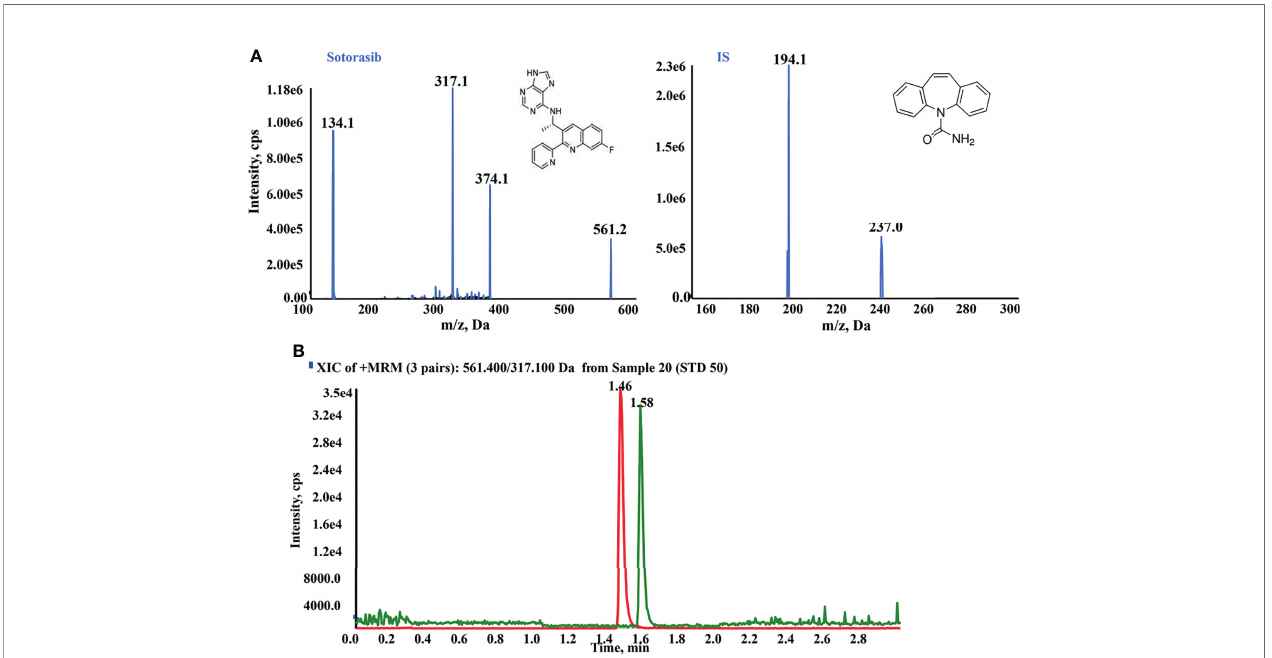
FIGURE 1 | High-performance liquid chromatography – tandem mass spectrometry (HPLC-MS/MS) conditions for the quantitation of sotorasib. (A) Product ion mass spectra and chromatogram of sotorasib and the internal standard (IS; carbamazepine) in ESI + mode. (B) Typical chromatogram of sotorasib (1.46 min) and IS (1.58 min) at the indicated retention